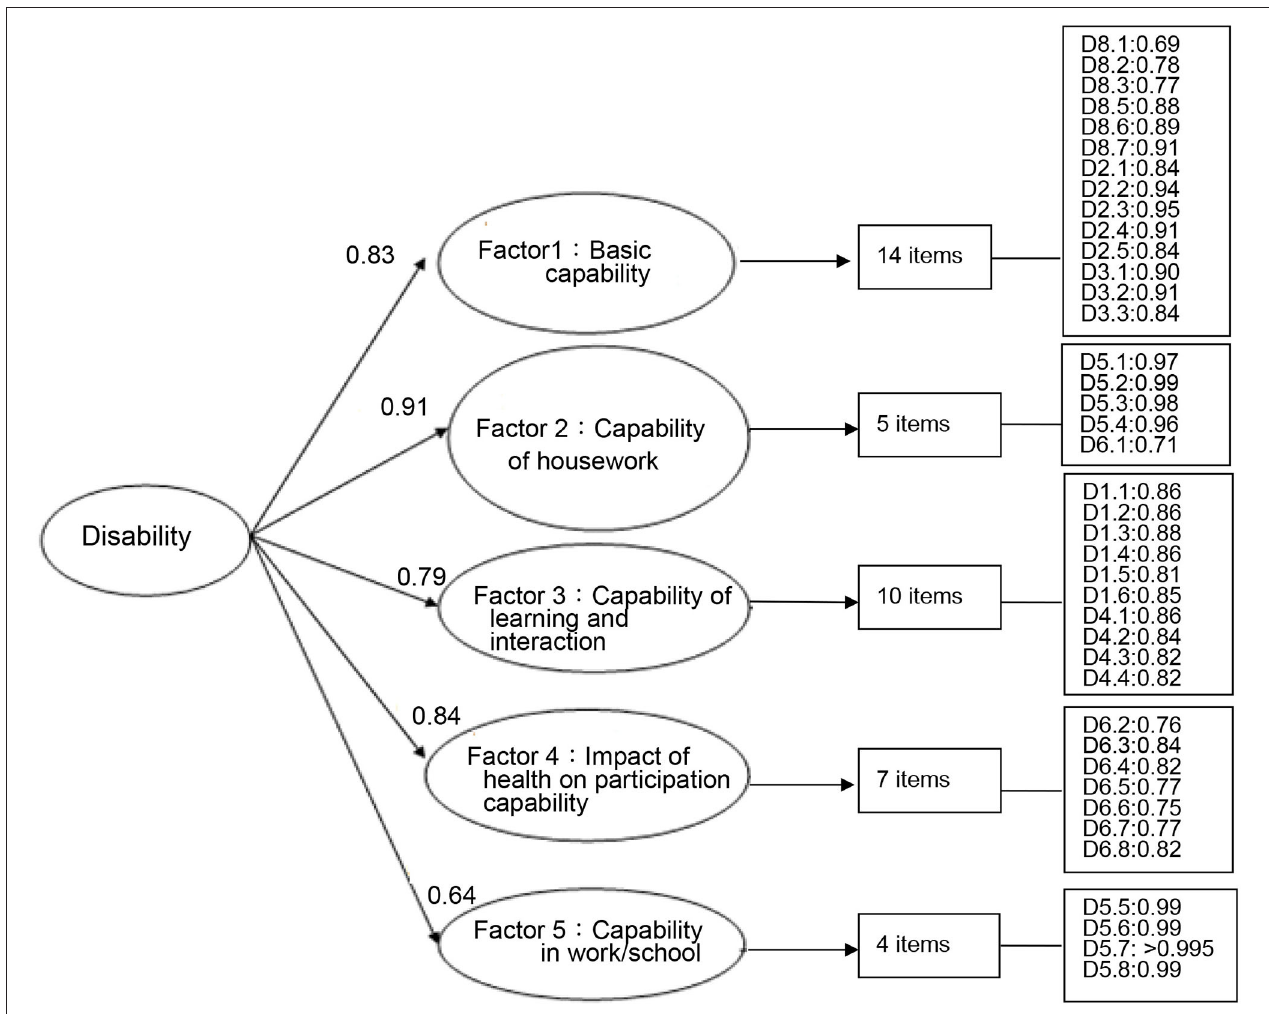
FIGURE 2 | Factor structure of the capability dimension of the FUNDES-Adult, version 7, by the CFA ( N = 500, 40 items); Fit indices (Bollen–Stine bootstrap p -correction estimated): TLI = 0.99, CFI = 0.99, NFI = 0.97, RMSEA = 0.087. model fit. All 40 items had factor loadings > 0.69 on